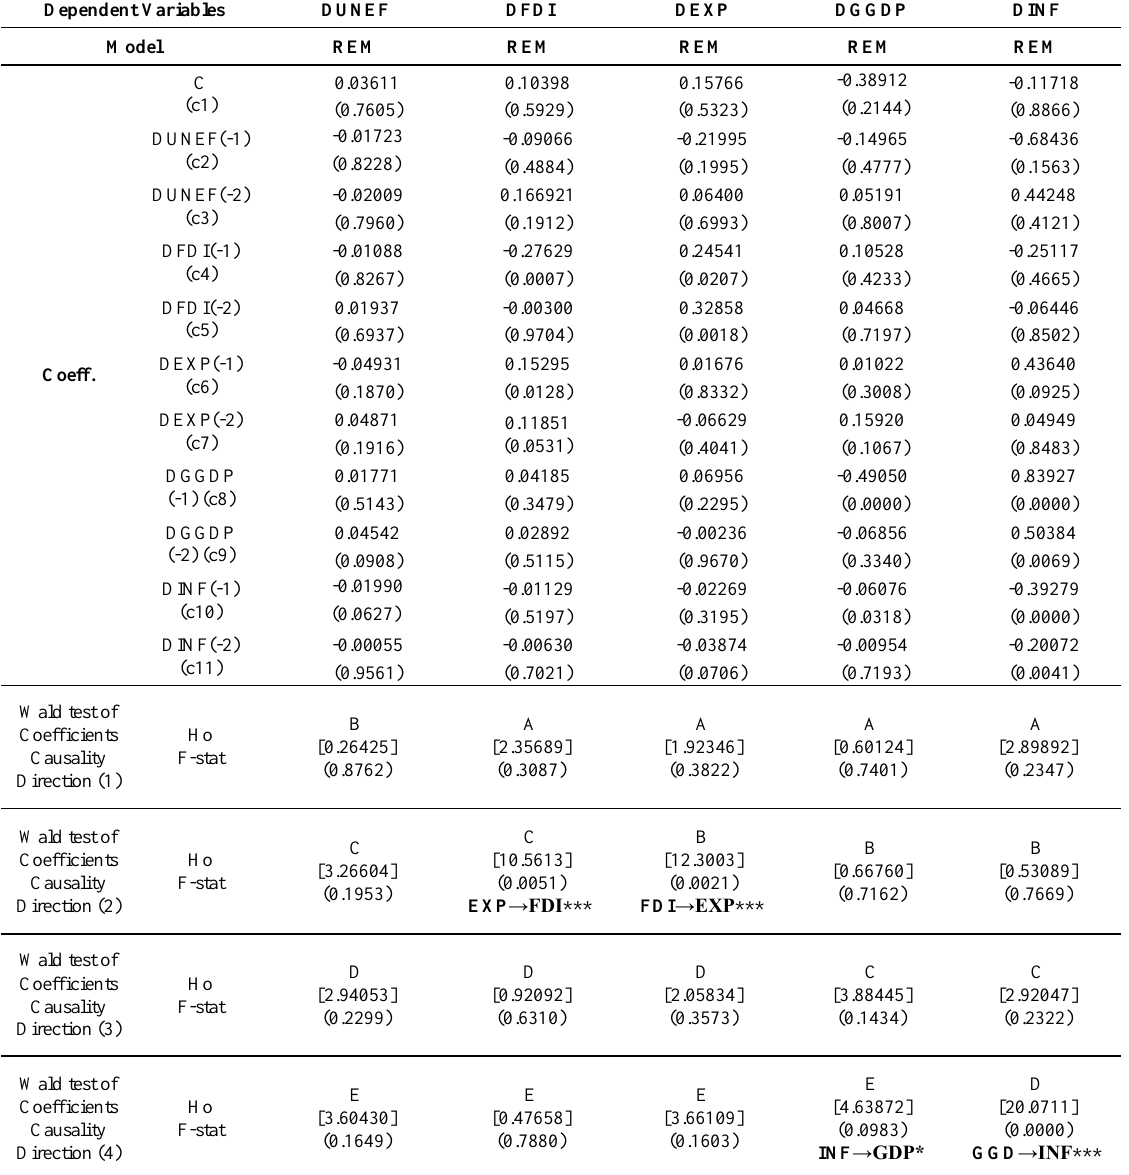
Table 11. Panel data Granger causality tests for the group of